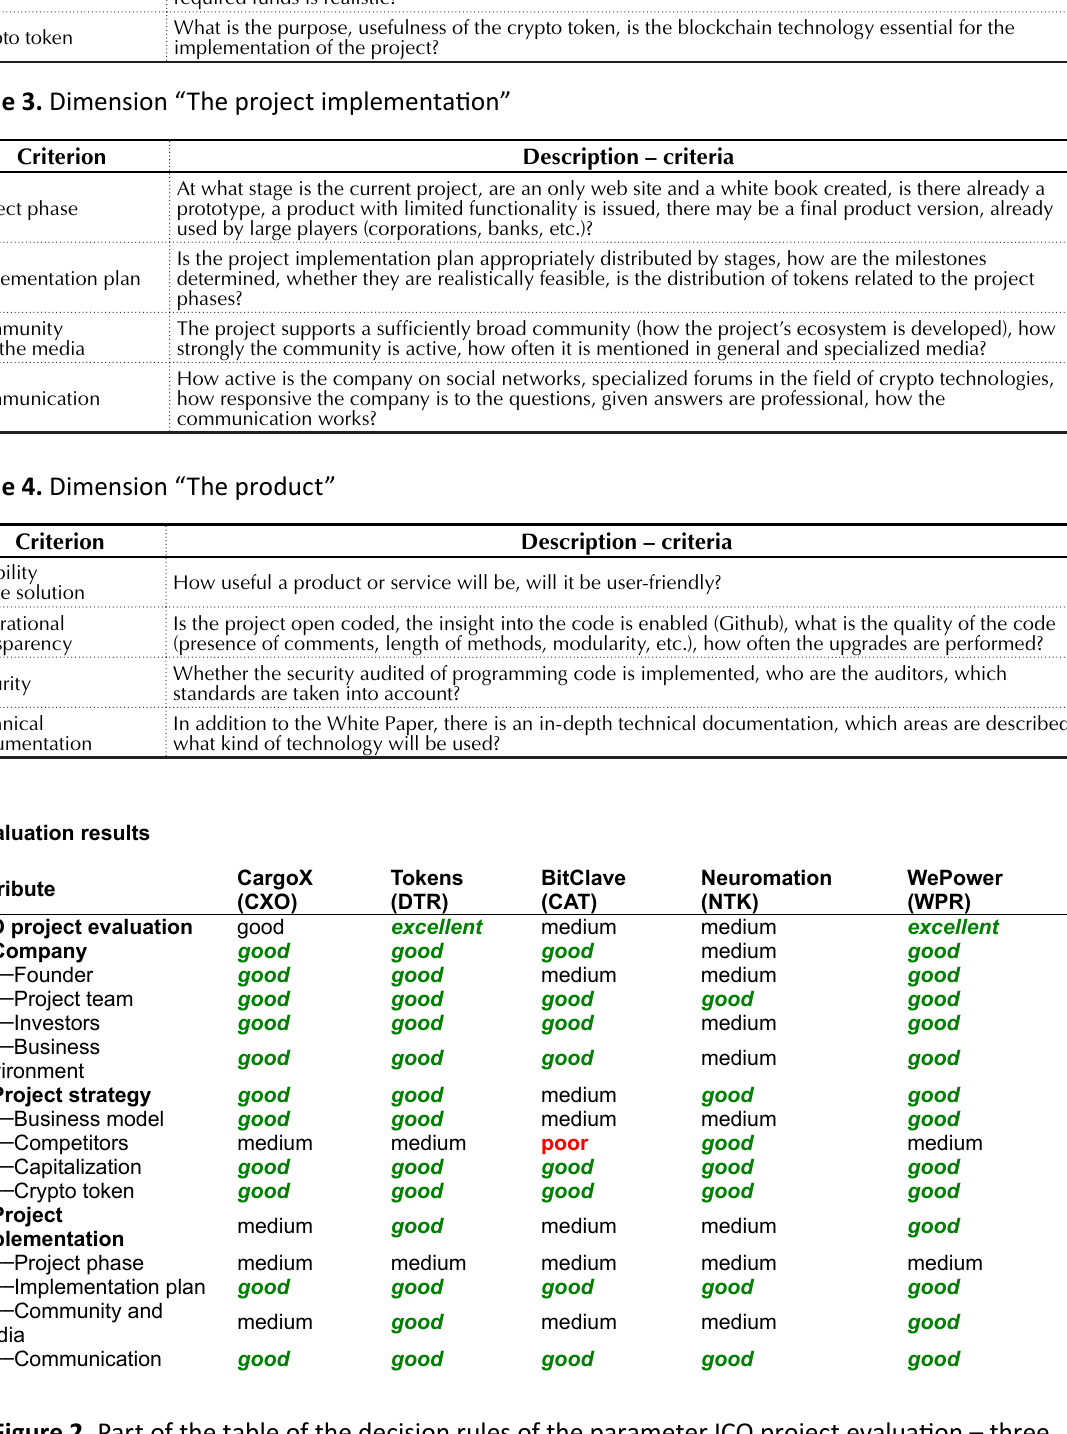
Figure 2. Part of the table of the decision rules of the parameter ICO project evaluation – three